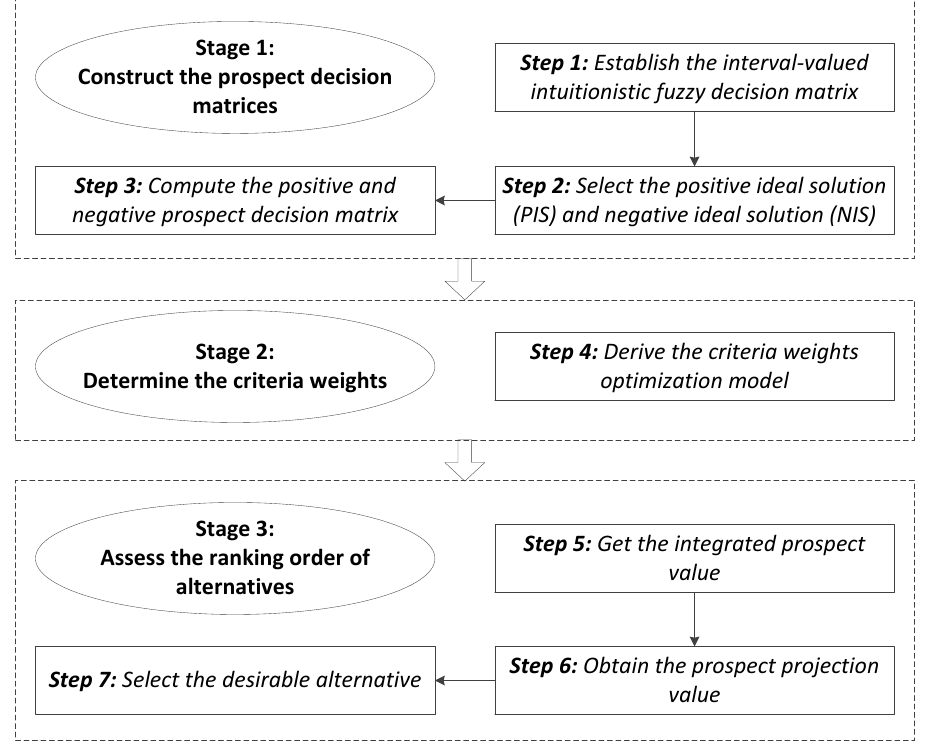
Figure 2. Interval-valued intuitionistic fuzzy prospect projection MCDM procedure.